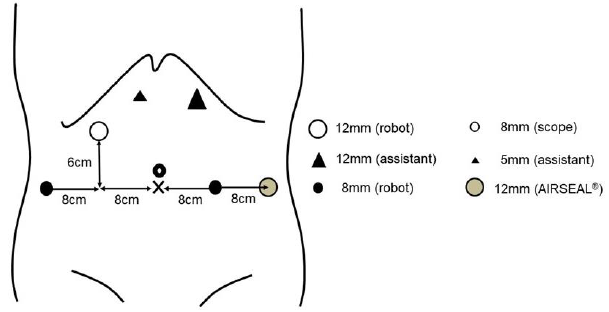
Figure 1. Port placements.